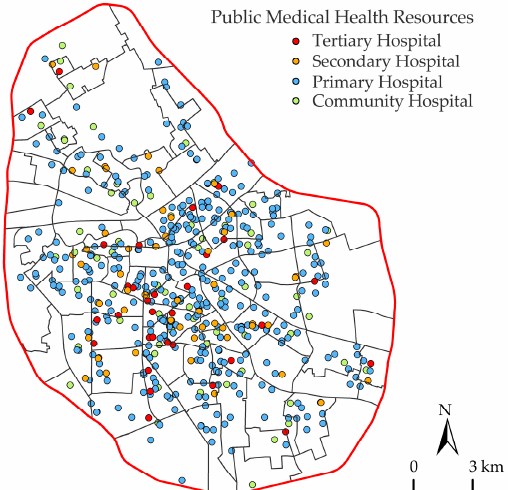
Figure 2. Spatial distribution of public medical health resources in the research area. Table 2. Reference standard for the number of beds in various function hospitals.